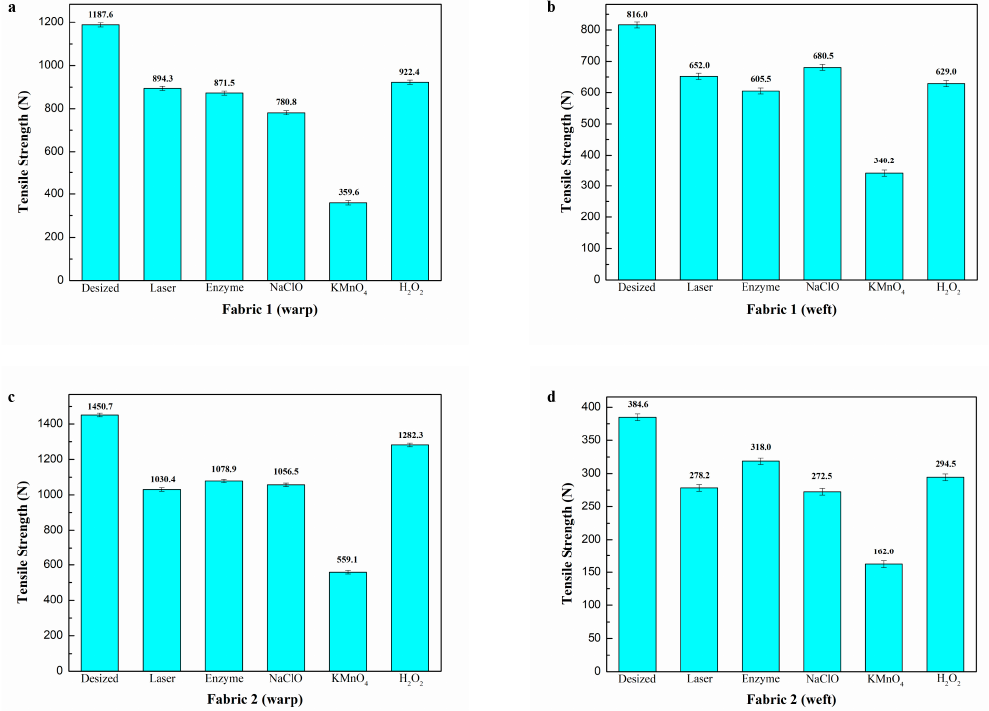
Table 5. Weight of denim fabrics with different bleaching types.